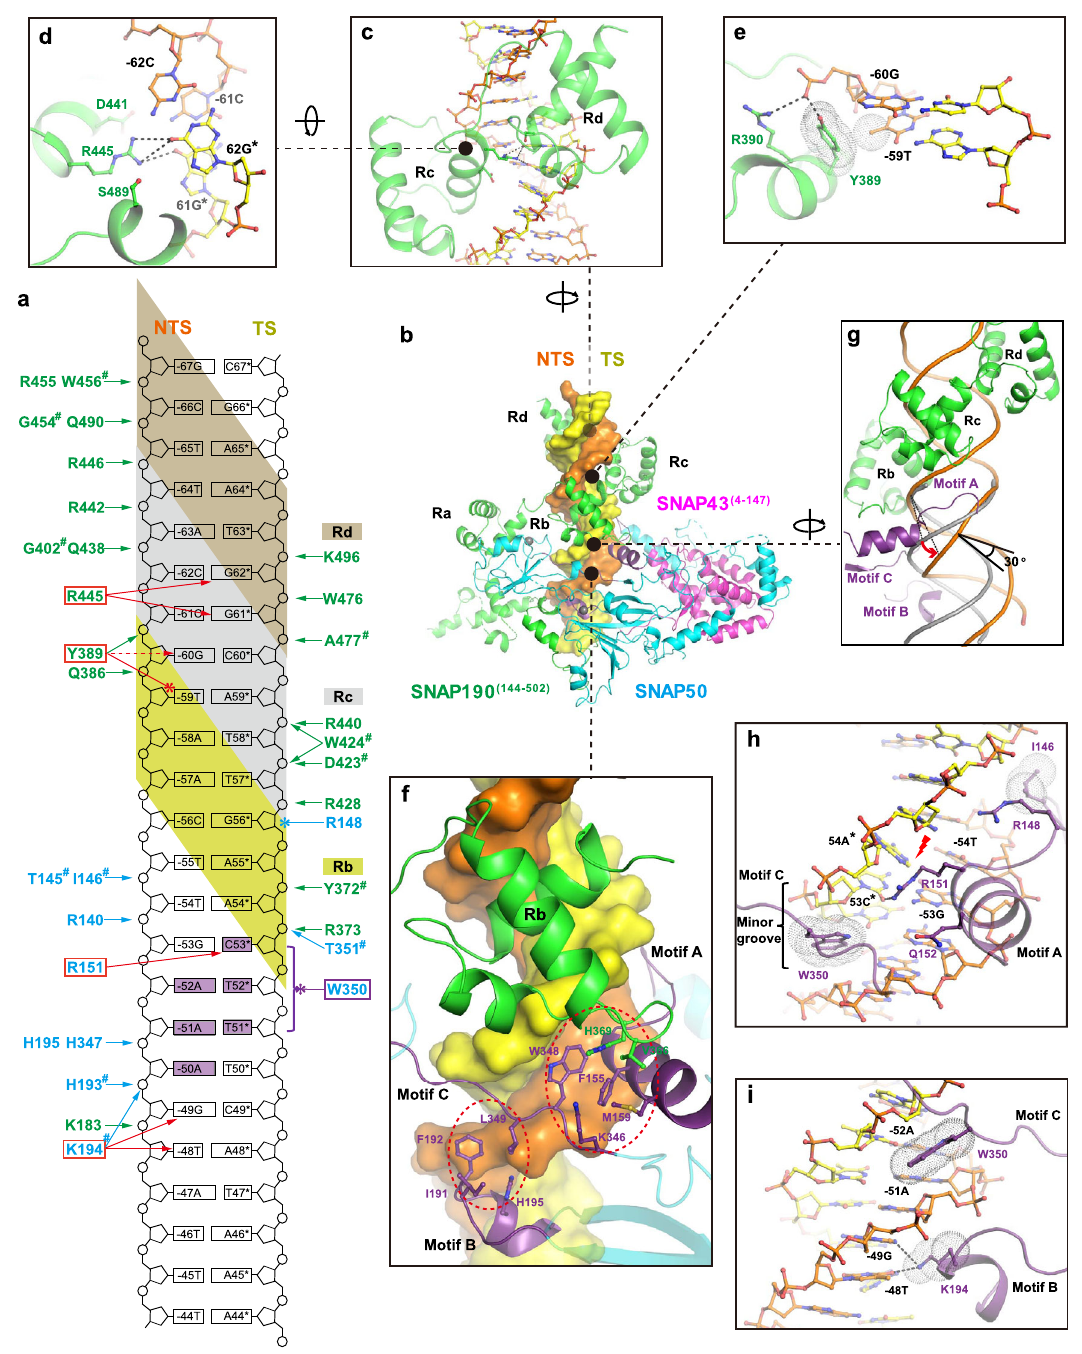
Fig. 3 | Structural insight into PSE-recognition by mini-SNAPc. a Schematic representation of 24bp hU6-1 PSE interacting with the corresponding residues of SNAPc. The hydrogen bonds and hydrophobic interactions are shown with arrows and clubs, respectively. Those residues using the main chain to interact with DNA arelabeledwithahash(#).Residuesguidingspeci fi cbase-interactionviahydrogen bonds are boxed in red, with one exception of W350 relying on hydrophobic interaction colored in purple. b Structural representation of PSE-recognition by mini-SNAPc.The DNAduplex is shown assurface, inwhich NTSand TSare colored in orange and yellow, respectively. c , d Close-up views ofthe Rc and Rd binding to PSE duplex. R445 of Rc domain forms hydrogen bonds with GC pairs at positions -61 and -62. D441 and S489couldhelp conformationalstability of the side chain of R445. e Y389 of Rb is fi xed in one speci fi c conformation with the help of -60G and -59T. f SNAP50 recognizes PSE through three Motifs (A, B, and C colored in purple